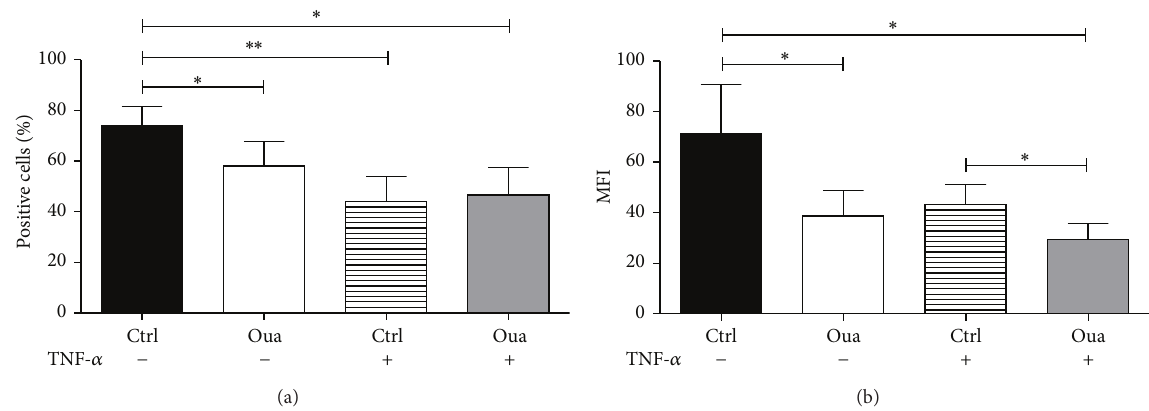
Figure 9: Phagocytic activity of dendritic cells cultured with Ouabain. After the differentiation period (5 days), cells were incubated for further 48 h with or without TNF- 𝛼 (50 ng/mL), in the presence or absence of 100 nM Oua. After this period, cells were incubated with FITC- dextran (0.5mg/mL) for 1h at 37 ∘ C and analyzed by flow cytometry. Data are expressed as the percentage of positive cells and MFI (mean fluorescence intensity) of positive cells (mean ± SEM of 6 independent experiments). ∗ and ∗∗ are significantly different from respective controls ((a): without TNF; (b): without Oua) ( ∗ 𝑃 < 0.05 ; ∗∗ 𝑃 < 0.01 ).